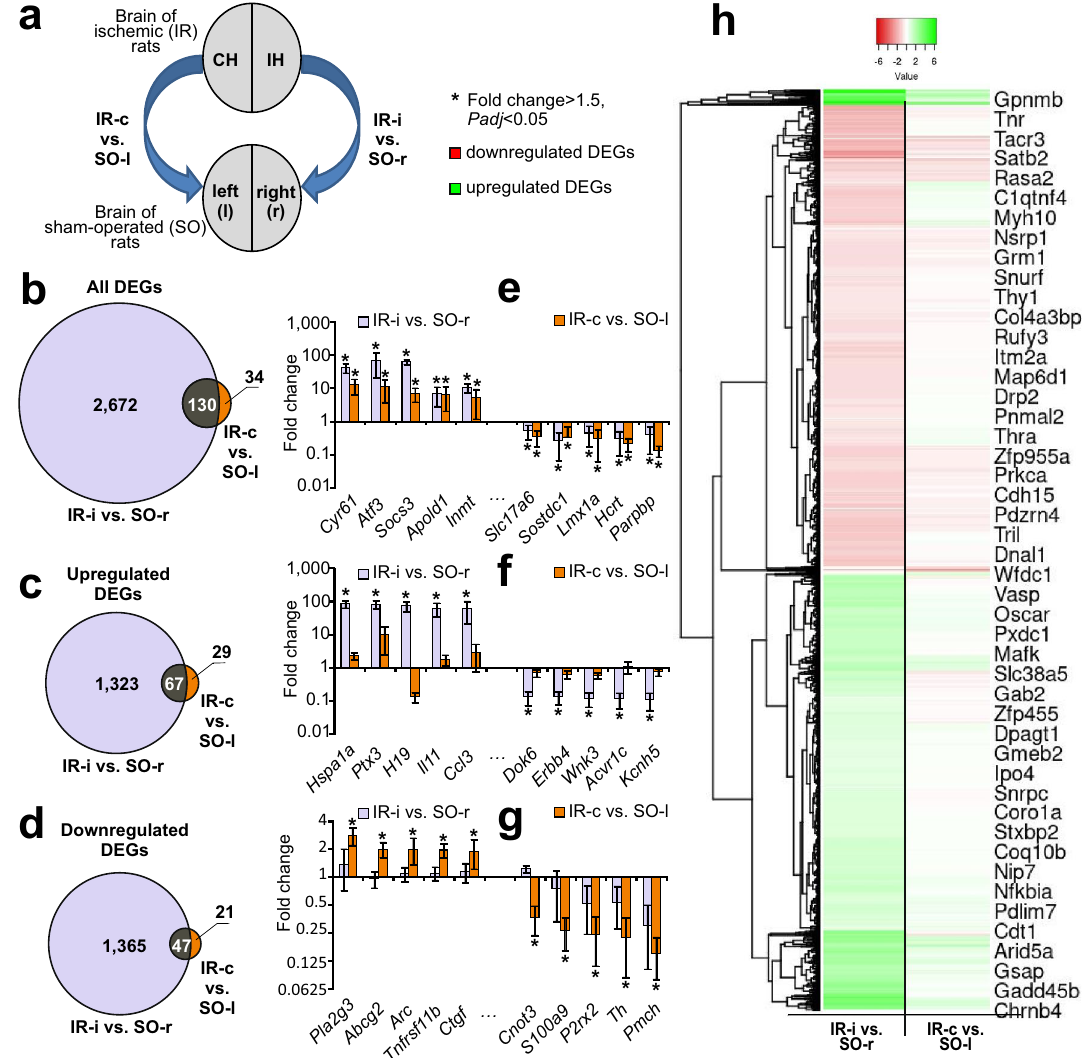
Figure 2. Comparison of RNA-Seq results for the CH and IH relative to the SO controls. ( a ) Comparisons of data are presented. Blue arrows indicate comparisons of ischemic (IR) brain samples versus the respective hemisphere in SO control rats. ( b – d ) Schematic comparisons of the results obtained for pairwise comparisons of IR-i vs. SO-r and IR-c vs. SO-l as represented by Venn diagrams. Comparison for all ( b ), upregulated ( c ), and downregulated ( d ) DEGs. The cutoff for gene expression changes was 1.50-fold, and only those genes with Padj < 0.05 were selected for analysis. ( e – g ) The top 10 genes that exhibited the greatest fold change in expression for IR-i vs. SO-r ( f ) or IR-c vs. SO-l ( e , g ) and that were within the gene sets on the Venn diagram are presented ( b – d ). DEGs that overlapped in pairwise comparisons of IR-i vs. SO-r and IR-c vs. SO-l are shown ( e ). DEGs for IR-i vs. SO-r but non-DEGs for IR-c vs. SO-l are shown ( f ). DEGs for IR-c vs. SO-l but non-DEGs for IR-i vs. SO-r are shown ( g ). Data are presented as the mean ± SE. Genes whose fold change was > 1.50 and Padj < 0.05 relative to the comparison group are marked with an asterisk (*). ( h ) Hierarchical cluster analysis of all DEGs for IR-i vs. SO-r and IR-c vs. SO-l. Each column represents a comparison group, and each row represents a DEG. Green stripes represent a high relative expression level and red stripes represent a low relative expression (n = 3 per